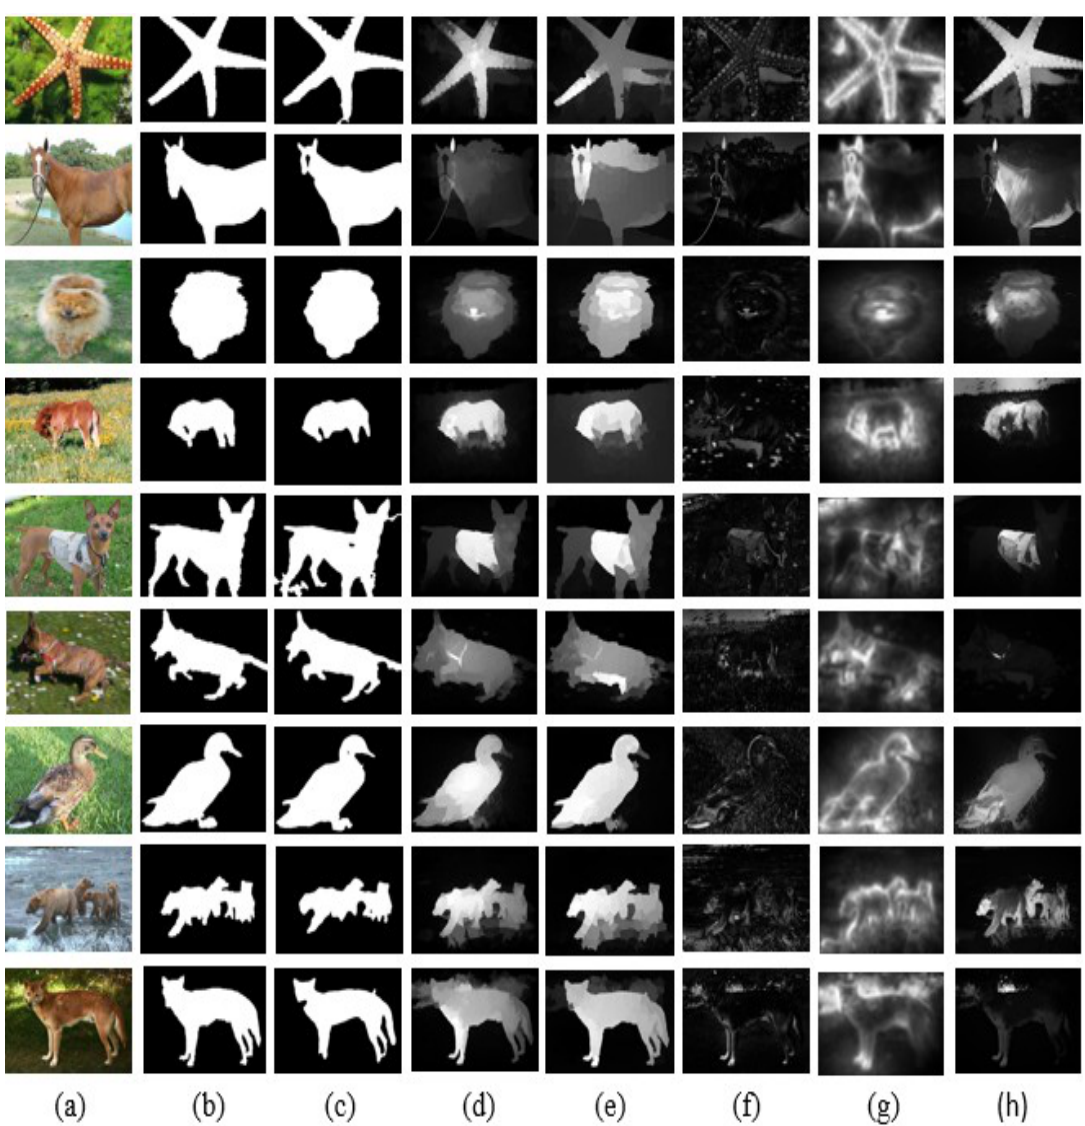
Figure 10. Qualitative comparison of the salience results of our model with those of five state-of-the-art models. ( a ) Original images; ( b ) ground truth; ( c ) results of our proposed algorithm ACCD-SOD; ( d ) results of the Transactions on Image Processing (TIP) method; ( e ) results of Visual saliency by extended quantum cuts (EQCUT); ( f ) results of the Context-aware saliency detection (CA) model; ( g ) results of the Achanta (AC) model; and, ( h ) results of the Saliency filters: Contrast based filtering for salient region detection (SF) model. Table 2. Average Runtime (Images Per Second) for Five State-of-the-art Methods and Our Method.